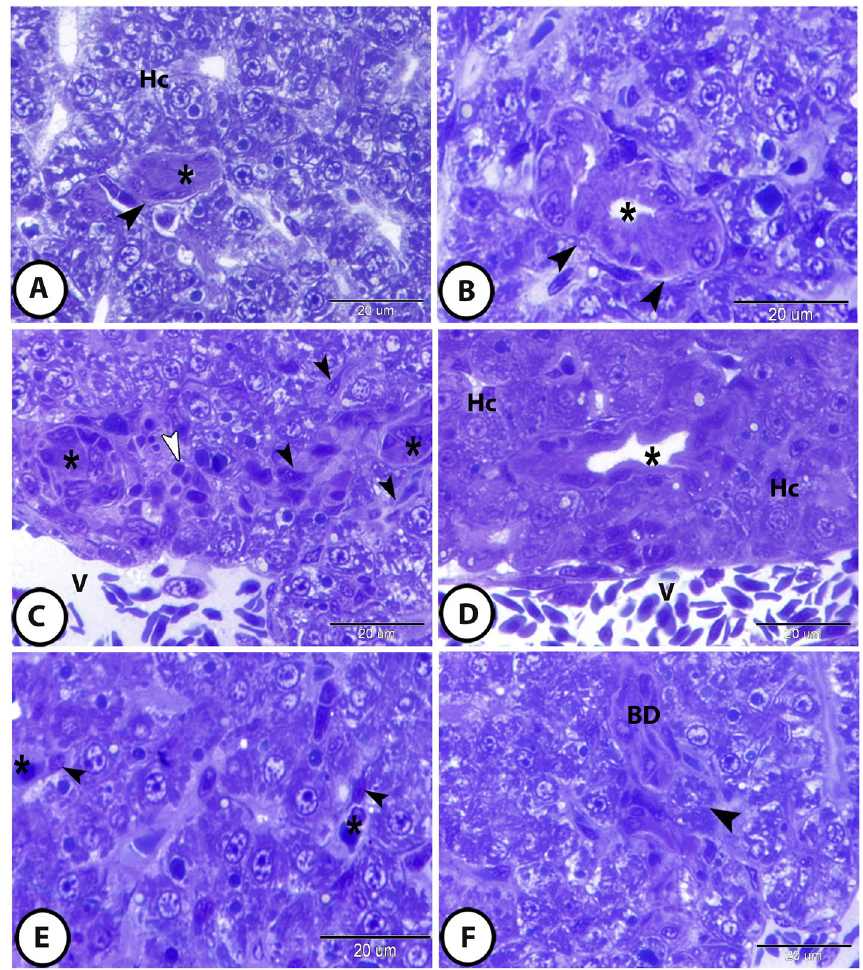
Fig. 2 Semithin sections of the stromal and cellular constituents of molly fish liver stained with toluidine blue. A and B The biliary tract system showed isolated type of distribution, the bile ductules (asterisks) were found independently within the hepatic parenchyma and were enclosed by connective tissue sheath (arrowheads). Hepatocytes (Hc) showed vacuolated cytoplasm containing abundant glycogen and lipid droplets. C and D The biliary tract system showed the biliary venous tract (BVT) type of distribution, the bile ductules (asterisks) were supplemented with portal venules (V) and were recognized within the hepatic parenchyma. Hepatocytes (Hc) showed deeply stained cytoplasm containing deeply stained inclusions. Telocytes (black arrowheads) and some immune cells (white arrowheads) were recorded within the connective tissue sheath surrounding the bile ductule. E Kupffer cells (arrowheads) showed cytoplasmic processes that protruded into hepatic sinusoid